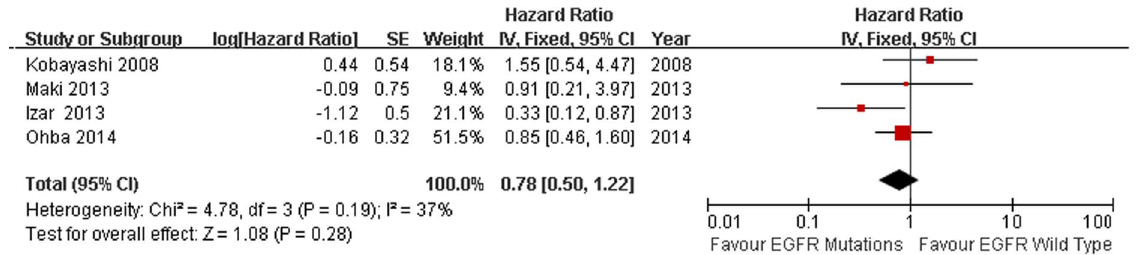
Figure 4. Fixed-effect model forest plot of HR of DFS in pathologic stage subgroup analysis according to EGFR mutation status. Solid diamond indicates the pooled HR of DFS, square indicates hazard ratio value of each study.